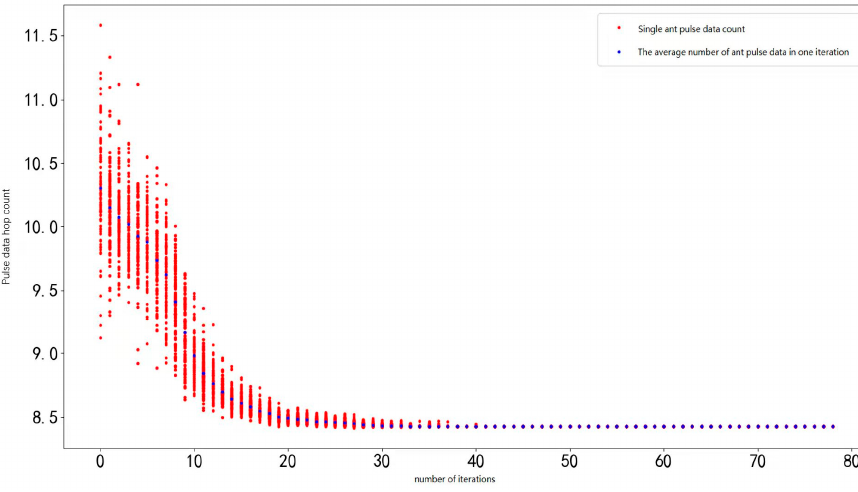
Figure 2. Mapping cost of the improved ant colony algorithm varies with the number of iterations.